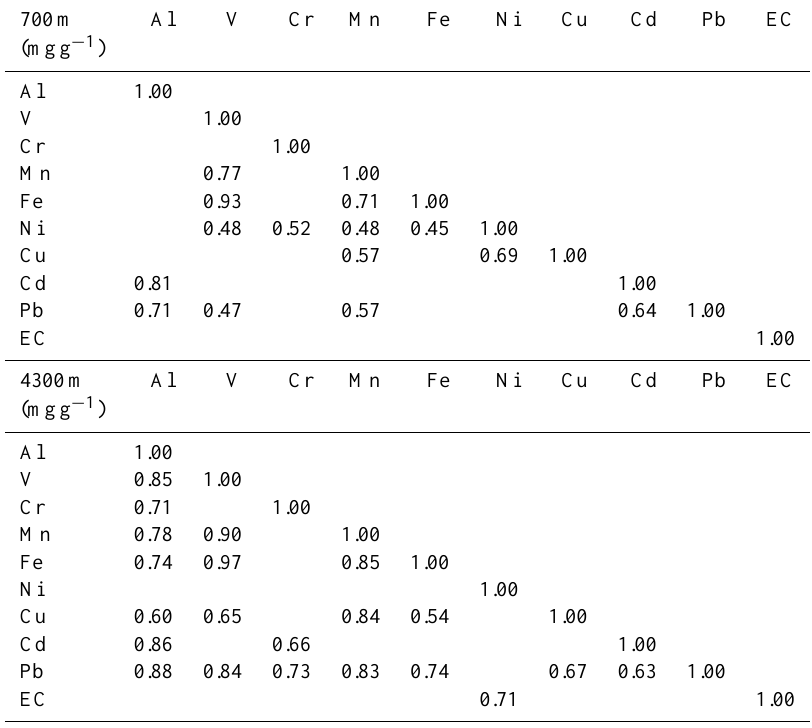
Table 3. Pearson correlation coefficients ( r ) between major and trace metals and EC concentrations (mgg − 1 ) determined at 700m and 4300m depth, respectively. 700m